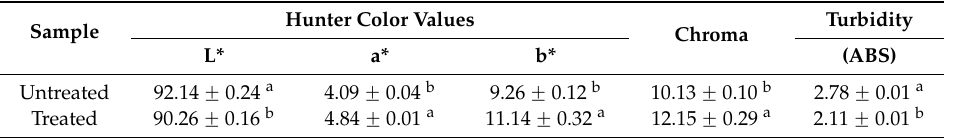
Table 3. Bulk density, water and oil absorption capacity of untreated and alkali-treated defatted rambutan seed flours.